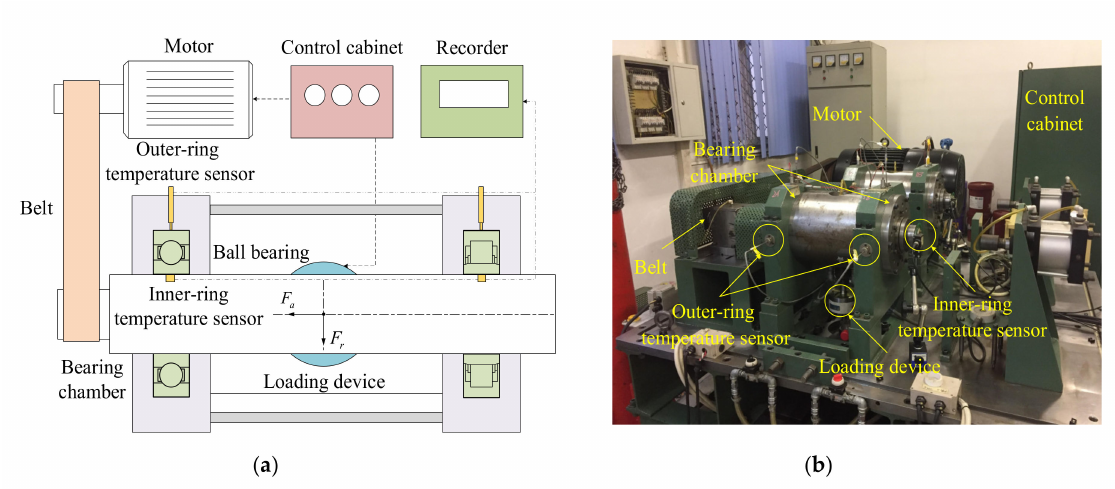
Figure 2. Overall block diagram and the experimental device on the bearing lubrication experiment bench for a high-speed traction motor. ( a ) Overall block diagram; ( b ) Experimental device.